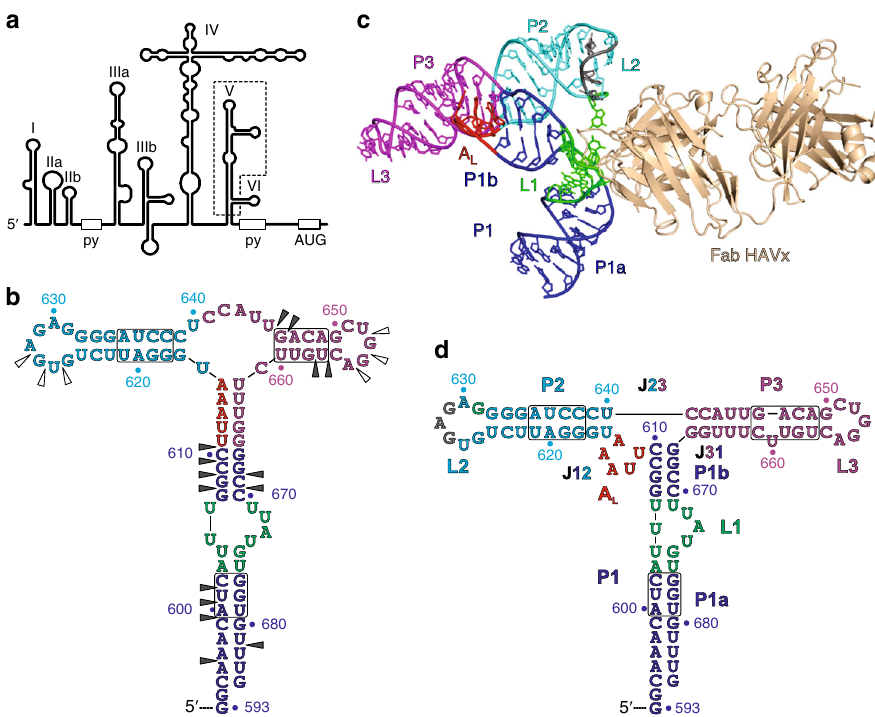
Fig. 1 Design of the HAV IRES dV crystallization construct and its overall structure in complex with Fab HAVx. a Proposed secondary structure of HAV IRES (wild-type HM175 strain) 28 showing major RNA domains (I – VI), polypyrimidine tracts (py) and the start codon (AUG). Dotted box highlights the dV crystallization construct. b Proposed secondary structure of the dV crystallization construct according to Brown et al 29 . Empty and fi lled arrowheads indicate sites of cleavage with dsRNA and ssRNA speci fi c RNases, respectively. Boxed regions indicate the sites of nucleotide covariations. c Global structure of the dV – Fab HAVx complex. d Secondary structure of dV derived from the crystal structure. Major structural elements and the corresponding nucleotides in b – d are colored analogously for facile comparison. Nucleotides involved in binding interactions with Fab HAVx and the nucleotides that form an A L are colored green and red, respectively. Modeling of three nucleotides G627 – G629 (colored gray in c , d ) was ambiguous due to poor electron